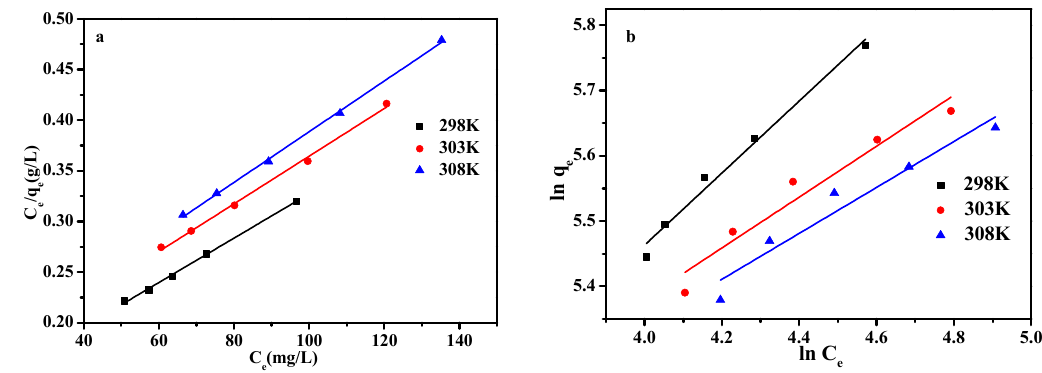
Figure 11. Adsorption isotherm of MB. ( a ) Langmuir isotherm and ( b ) Freundlich isotherm.